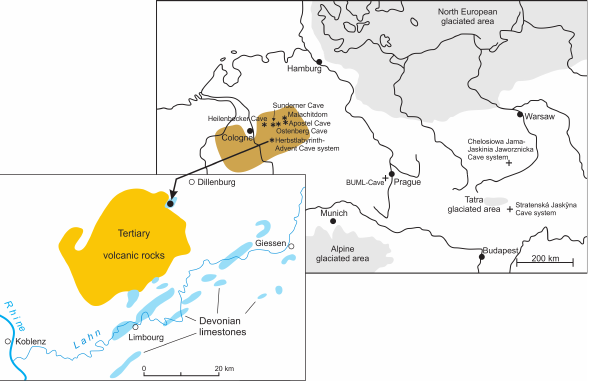
Fig. 1. Map showing the position of the Herbstlabyrinth-Advent Cave system as well as other caves of Central Europe from which cryocalcite has been described (light brown – Rhenish Slate Moun- tains, light grey – Weichselian glaciated areas). See lower left inset for more details.